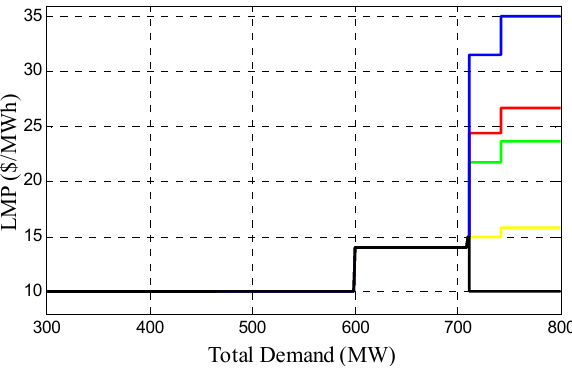
Figure 4. LMP on buses with different demand level.